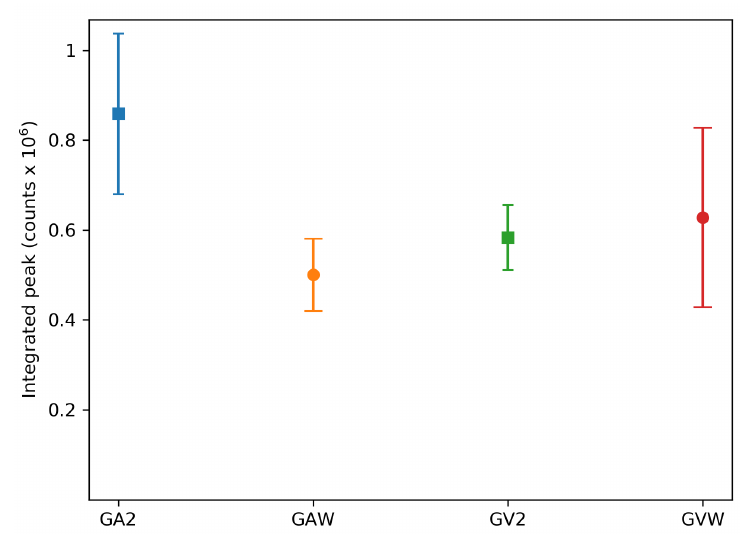
Figure 9. Integrated peak intensity from 1050 nm to 1100 nm corrected for the background for the unwashed and washed samples.